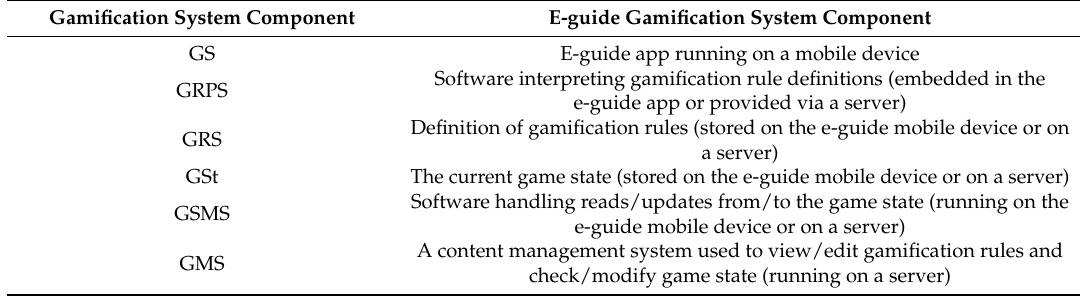
Table 2. The implementation of gamification system components in e-guide gamification